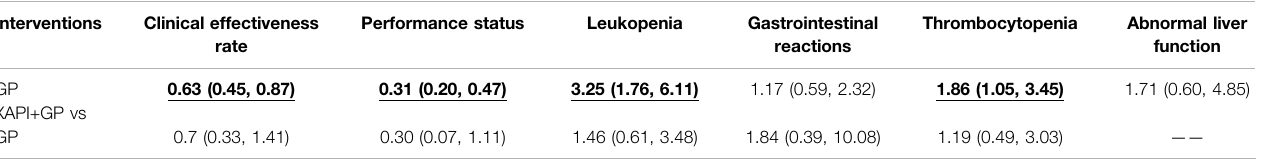
TABLE 2 | ( Continued ) Odds ratio/mean difference (95%CI) of all therapeutic interventions.